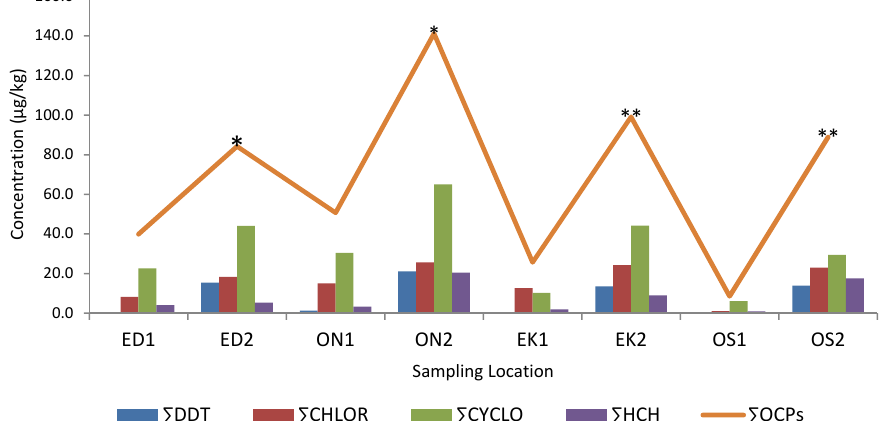
Fig. 3: Contamination level of OCPs group in the study Figure 3 : Contamination level of OCPs group in the study area